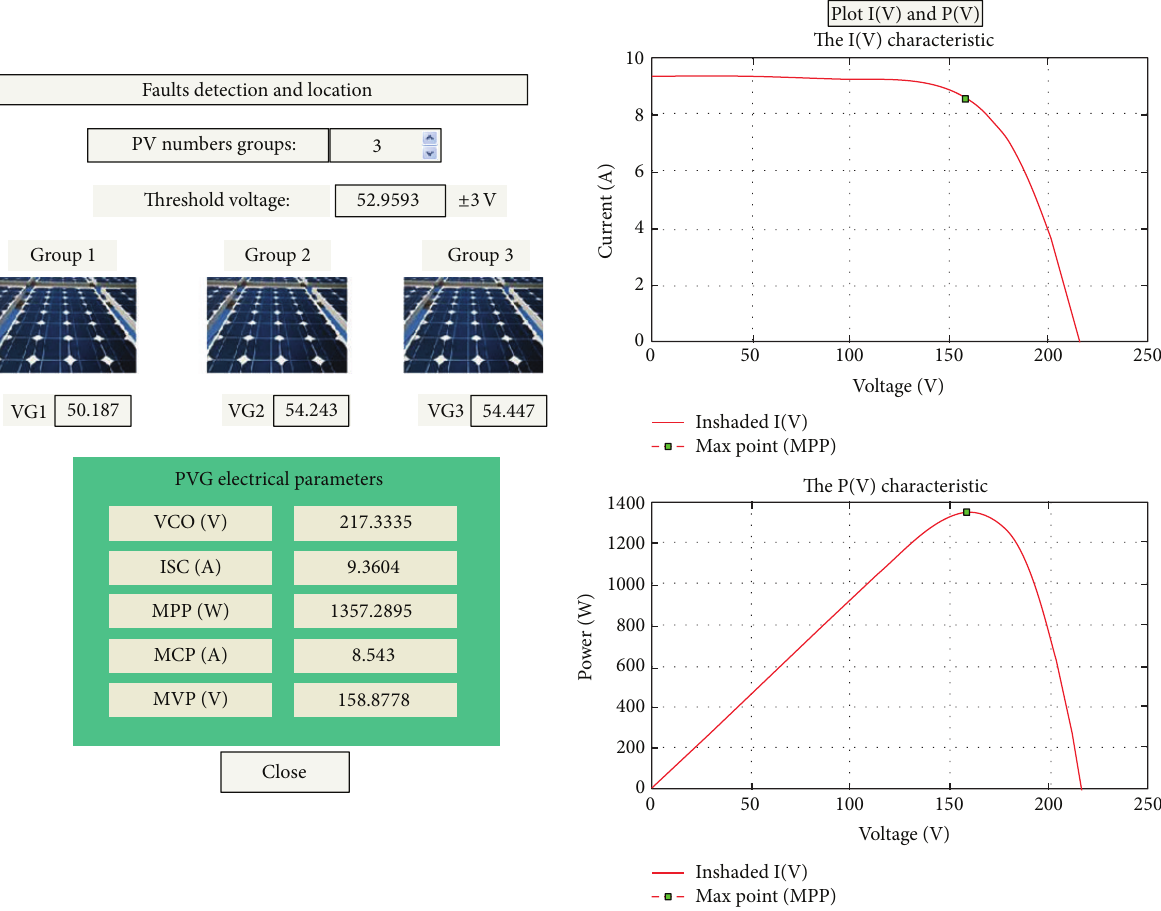
Figure 10: Screenshot of the GUI in case of inshaded